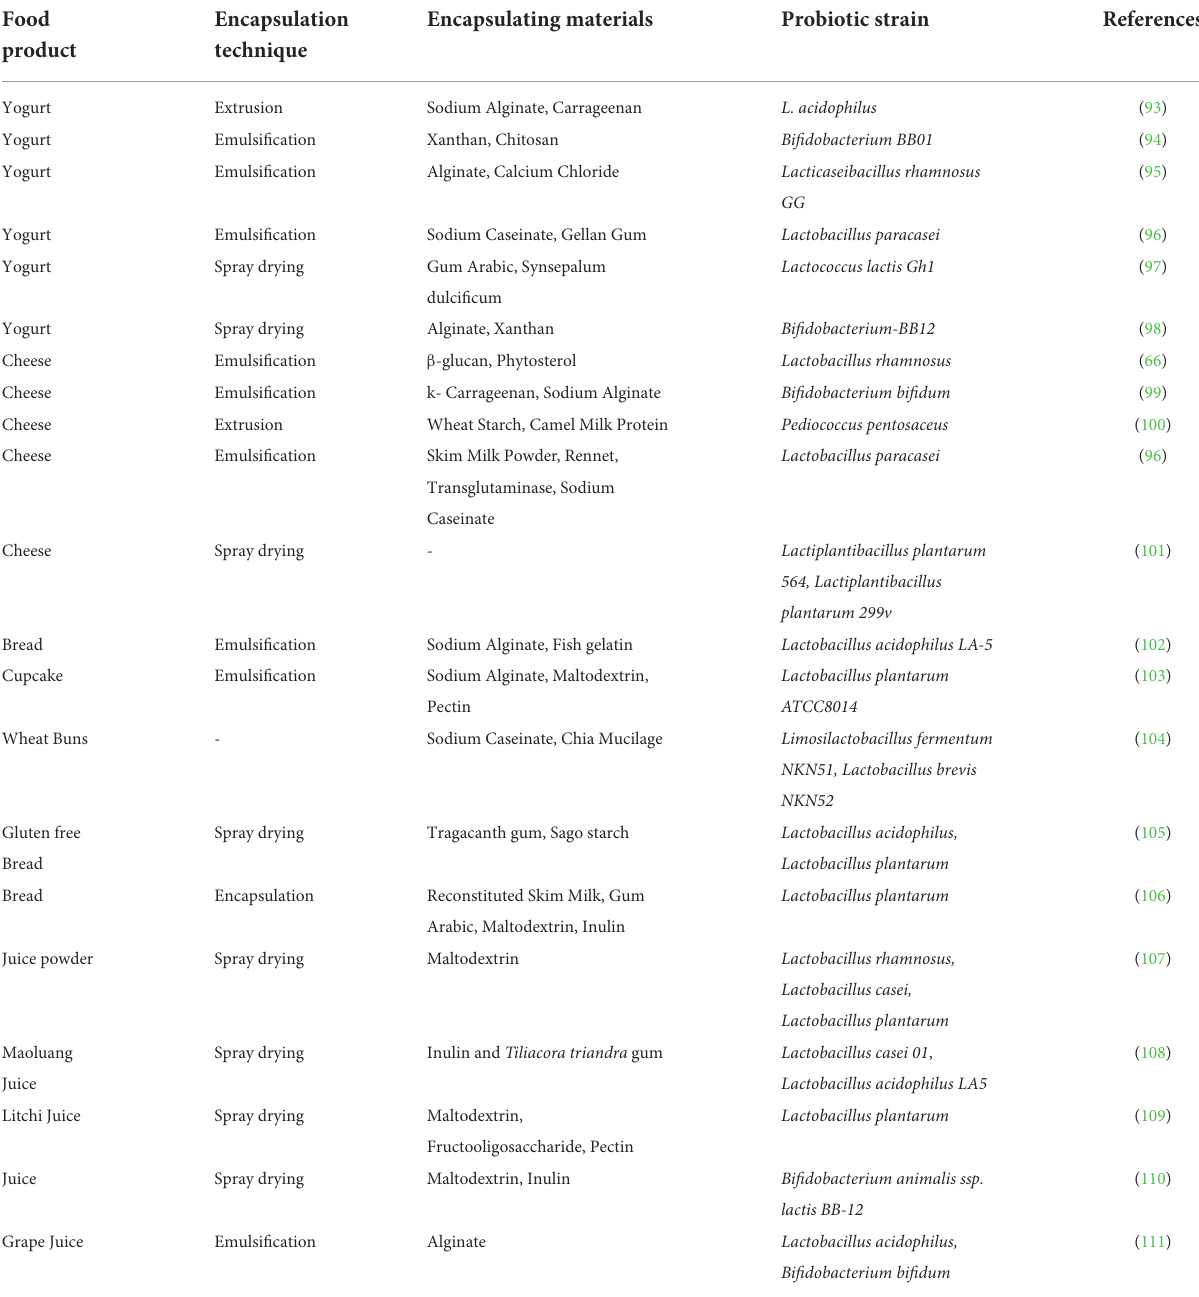
TABLE 3 Applications of encapsulated probiotics in functional food